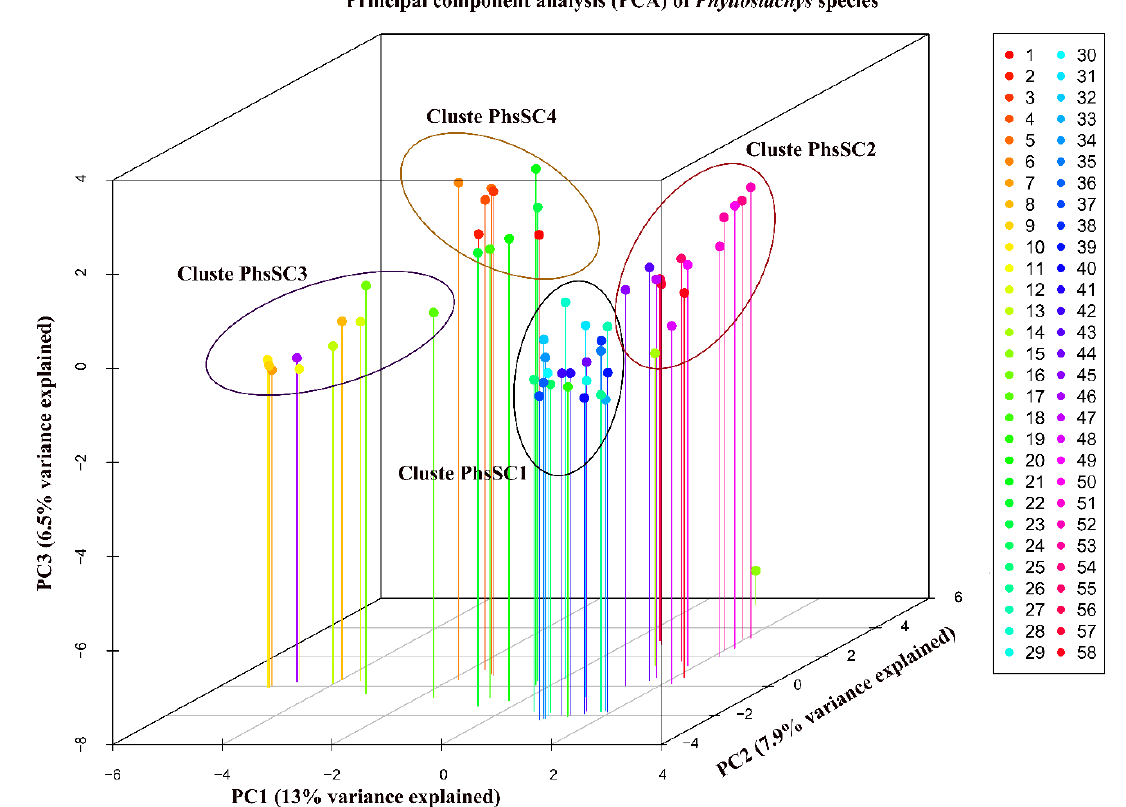
Figure 5. Scatter diagram of three-dimensional principal component analysis (PCA) showing the distribution of 58 Phyllostachys species (Asian bamboo) based on inter-retrotransposon amplified polymorphism (IRAP) markers. PC1 (X-axis), PC2 (Y-axis), and PC3 (Z-axis) are the first, second, and third principal components, respectively. Numbers 1–58 on the right side represent different Asian bamboo species as defined in Table 1.